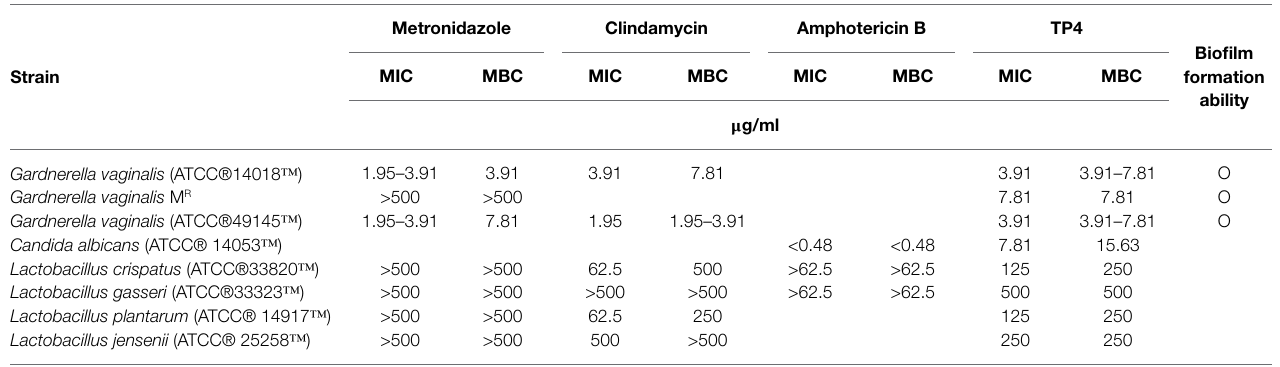
TABLE 2 | Comparative susceptibility of Gardnerella vaginalis , Candida albicans , and vaginal lactobacilli to TP4 and antibiotics.